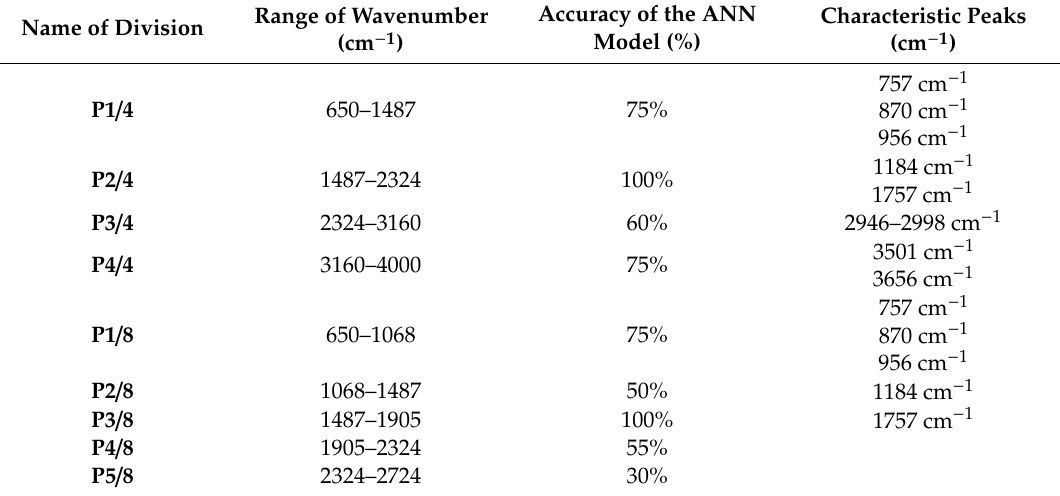
Table 2. Accuracy of the artificial neural network (ANN) model according to the range of wavenumber.